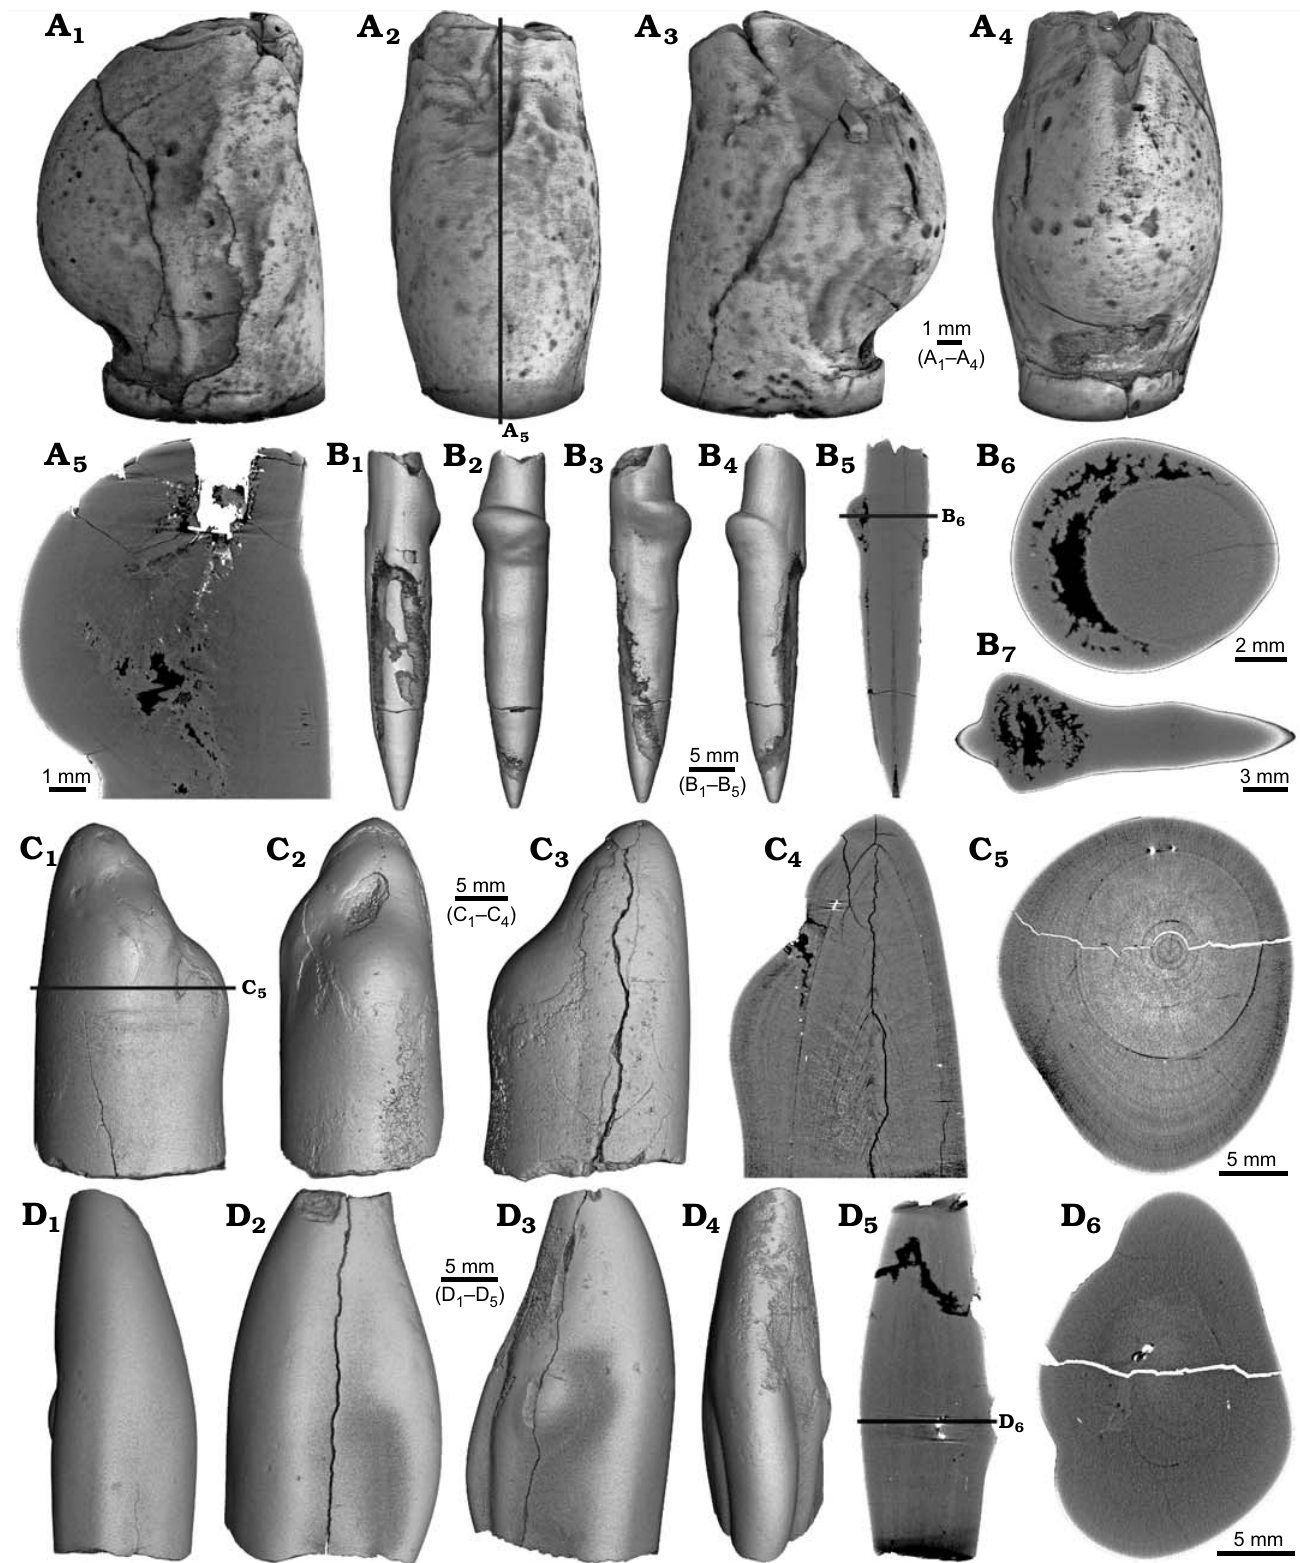
Fig. 4. A . Rostrum of belemnite cf. Hibolithes jaculoides Swinnerton, 1937, SNSB-BSPG-83251, Hauterivian, Heligoland (N-Germany) with forma aegra bullata (coll. H. Keupp). Surface images showing the bump-shaped irregular rostrum growth, in lateral (A 1 ), dorsal (A 2 ), lateral (A 3 ), and ventral (A 4 ) views. Longitudinal section showing open pore space partially filled with carbonate cements (A 5 ). B . Rostrum of belemnite Goniocamax sp., MGUH 32024, Santonian, Bav nodde (Denmark) with forma aegra bullata (coll. J. Ansorge). Surface images of the rostrum showing the bump-shaped irregular